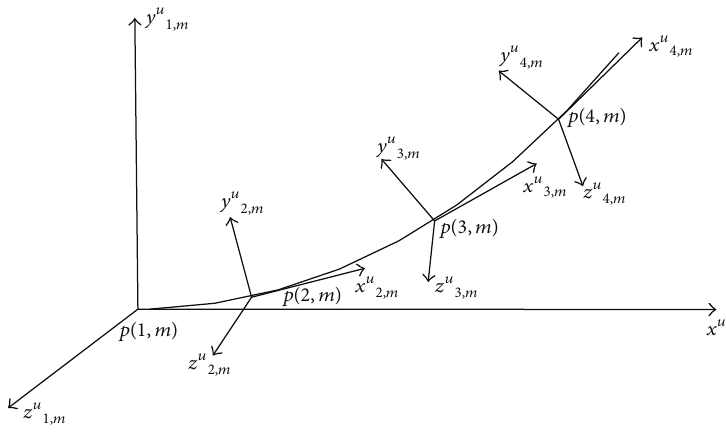
Figure 3: Moving coordinate system.